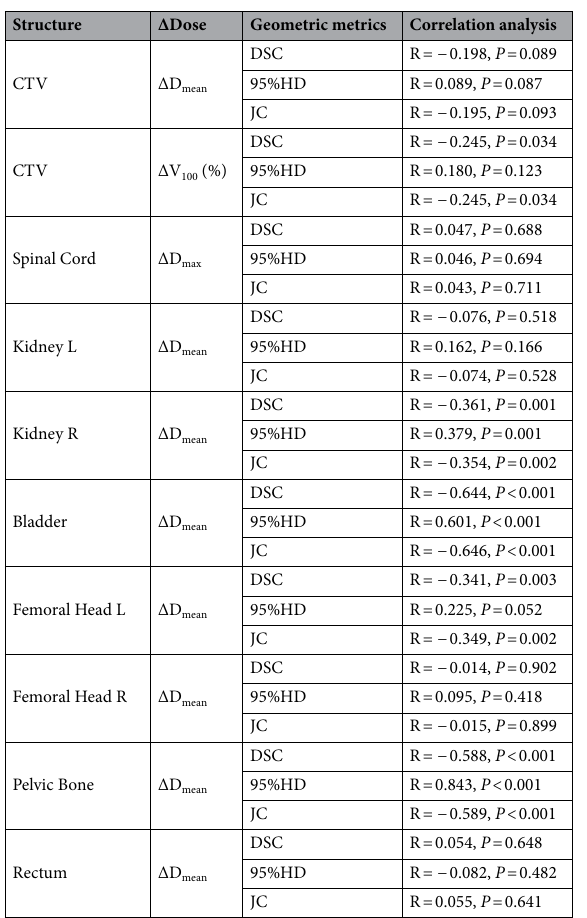
Table 3. The correlation between geometric metrics and dosimetric differences. DSC: dice similarity coefficient; HD: hausdorff distance; JC : jaccard coefficient; ΔDose : dosimetric differences between two segmented